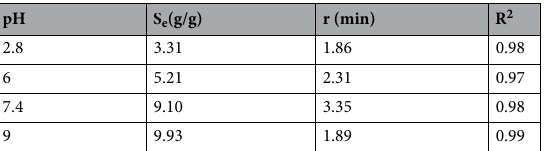
Table 1. The values of the equilibrium swelling ( S e ), the rate parameter (r), and the coefficient of 2 determination ( R ) obtained at different pHs for BC-based CH.